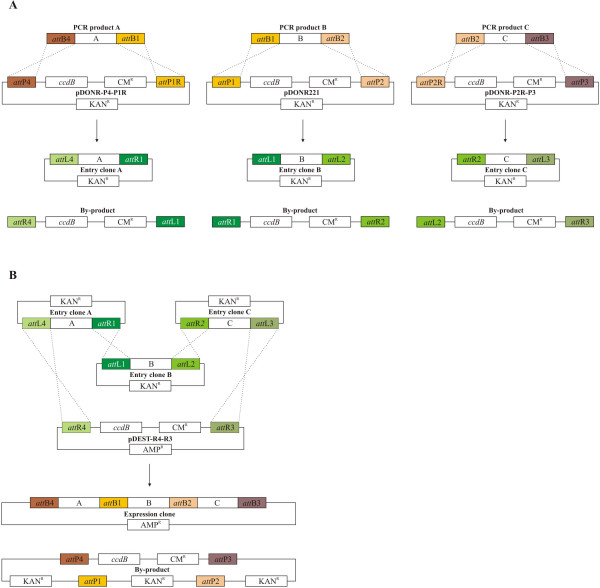
MultiSite Gateway. (A) BP recombinations of three PCR products "A", "B" and "C" flanked by attB sites with three Gateway donor vectors [7]. (B) LR plus recombination of three entry clones bearing the DNA fragments "A", "B" and "C" with the MultiSite Gateway destination vector pDEST-R4-R3 (Invitrogen) [7].